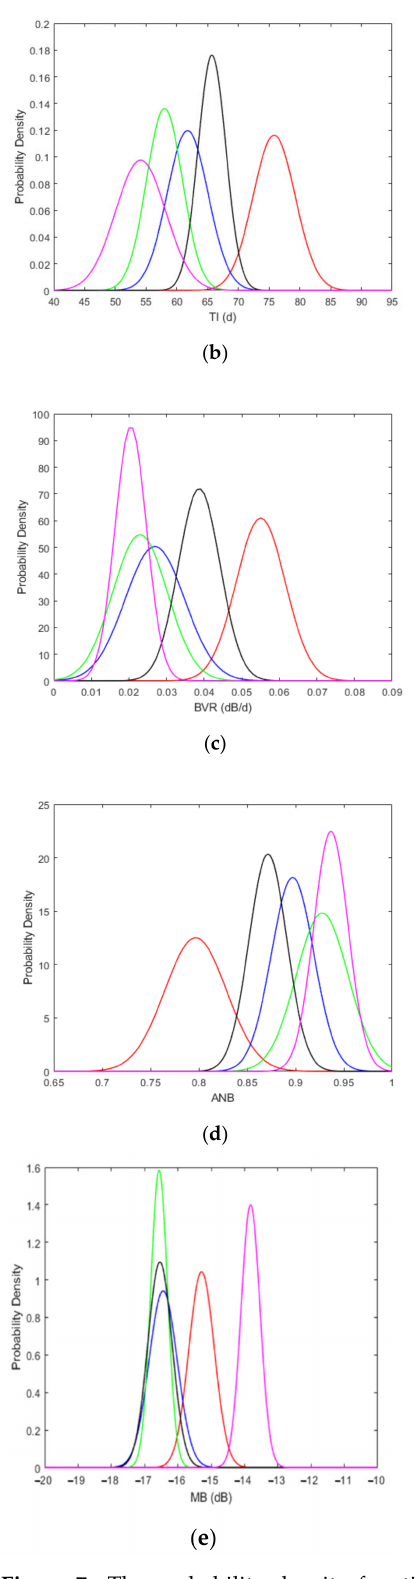
Figure 7. The probability density functions for VH polarization with ascending orbit mode of proposed features of ( a ) backscatter difference (BD), ( b ) time interval (TI), ( c ) backscatter variation rate (BVR), ( d ) average normalized backscatter (ANB) and ( e ) maximum backscatter (MB). Rice is shown in red, maize in blue, peanut in green, wheat in black and onion in